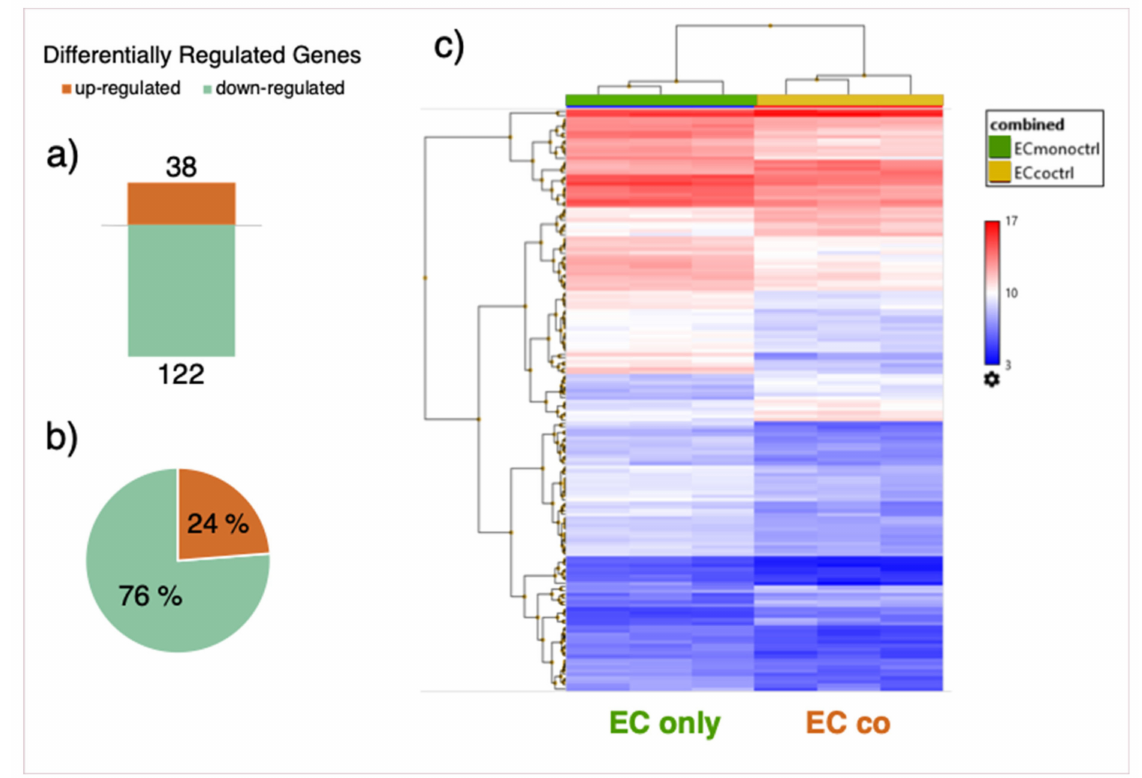
Figure 6. Differentially regulated genes (DRGs). Number of DRGs in co-cultured vs. mono-cultured endothelial cells (ECs). A total of 38 genes were upregulated, while 122 genes were downregulated ( a ). Pie chart representation of the same data as in ( a ) denoting up-and downregulated genes in% of total number of DRGs ( b ). Heat map representation of DRGs ( c ). Comparison of gene expression data in co-cultures vs. mono-cultured ECs was performed by using Transcriptome Analysis Console (TAC, Applied Biosystems). For the analysis, a fold change (FC) cut-off of 1.5 (log2FC ± 0.59) and an FDR p-value of 0.05 were applied.